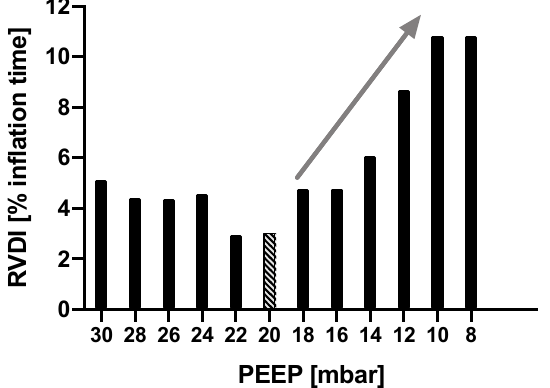
Figure 2. Measurements of time disparities (regional ventilation delay inhomogeneity [RVDI]) derived from slow inflations during a decremental positive end-expiratory pressure (PEEP) trial. RVDI is minimized at a PEEP of 20 cm H 2 O. Below this PEEP, RVDI progressively increased (see arrow), which suggested that tidal recruitment also increased [16,18]. Thus, a PEEP of 20 cm H 2 O was presumably associated with minimal tidal recruitment [17].